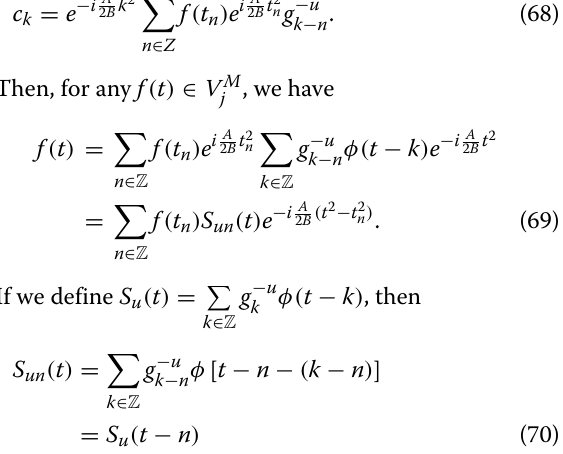
Fig. 9 The original, sampling points and the reconstructed signals